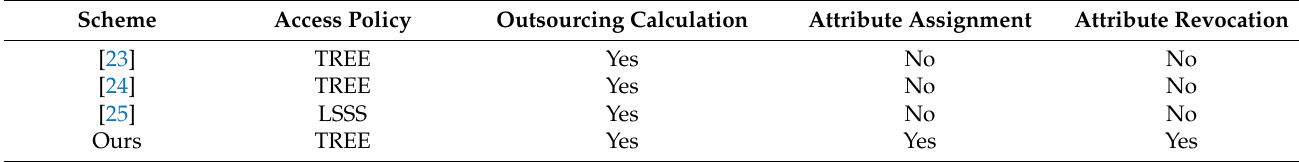
Table 2. Comparison of